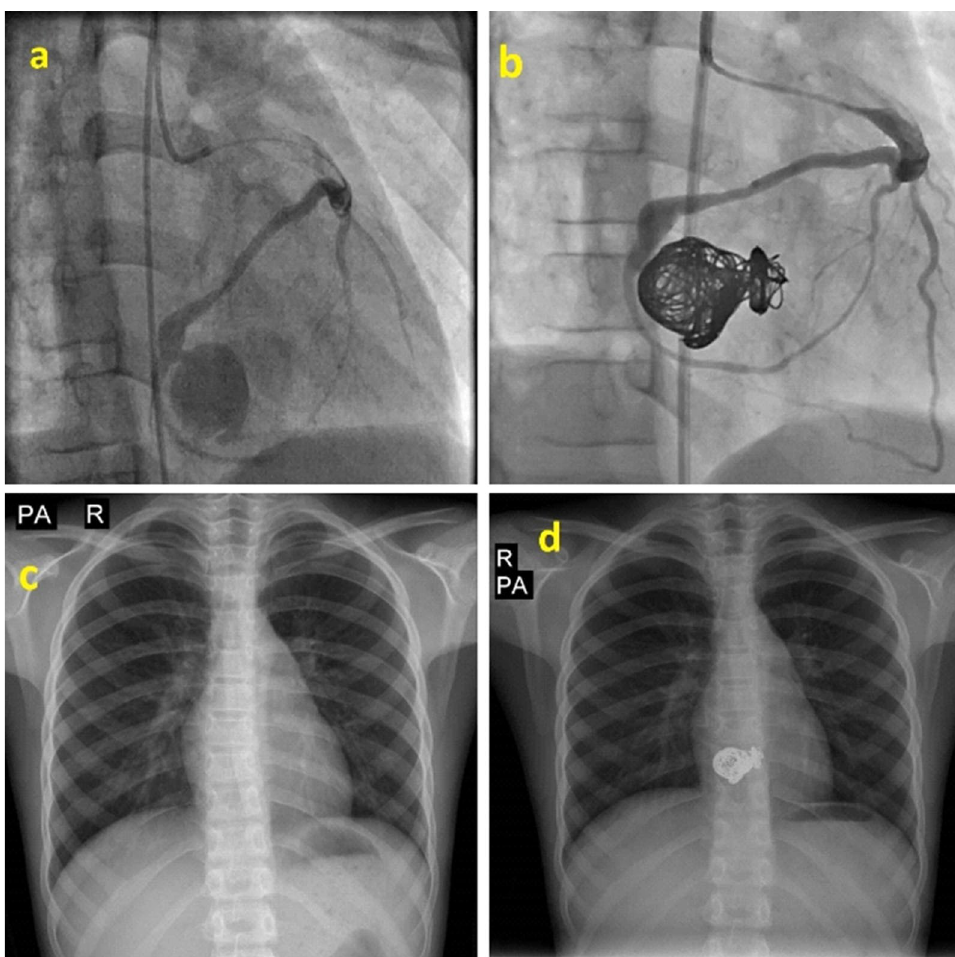
Fig. 2 Large coronary aneurysm with RCA to RV before and after intervention. a , b ; Large coronary aneurysm with RCA to RV fistula that closed via retrograde approach with 8 coils. c , d ; Patient’s CXR before and after intervention